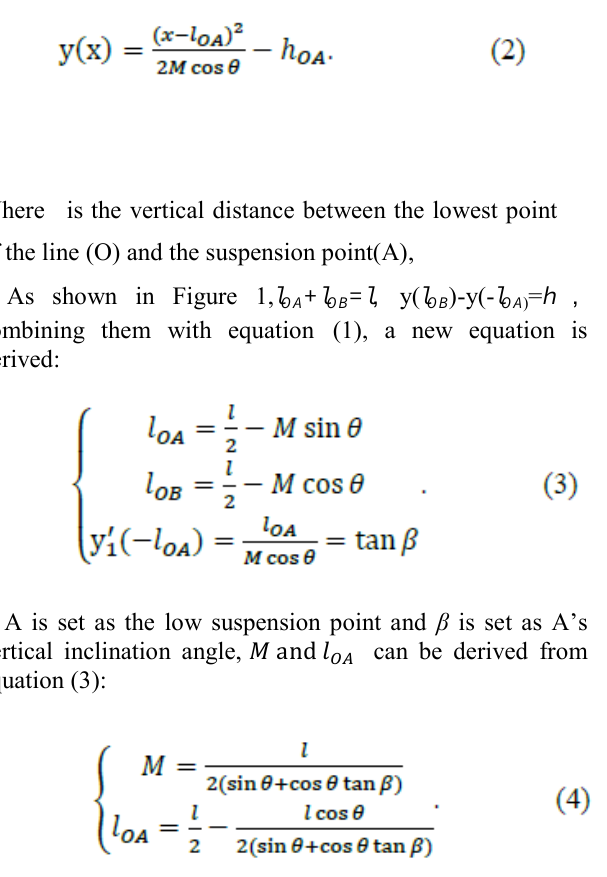
The crossed span distance of two static lines